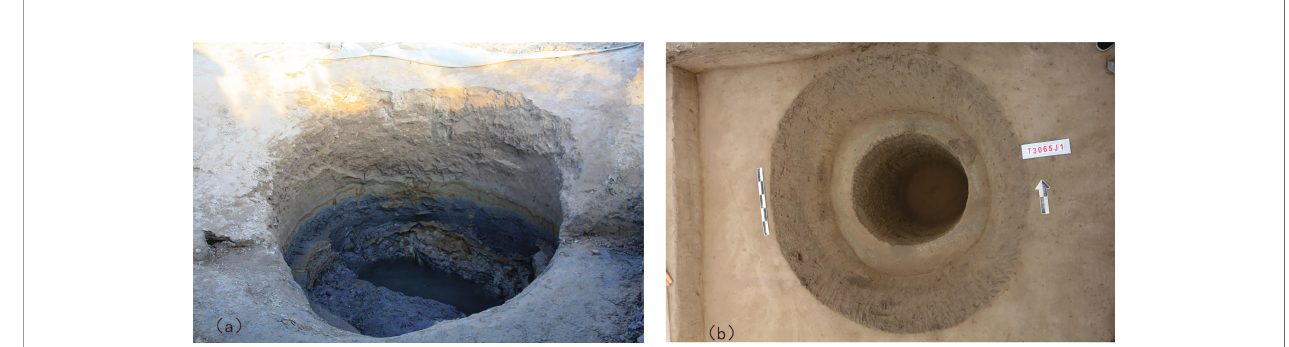
FIGURE 8 | Brine wells discovered in salt production sites. (A) Brine well showing the underground brine layer at the SWC site of the Shang and Zhou Dynasties. (B) Brine well discovered at the Jixielinchang site of the Eastern Zhou Dynasty (provided by